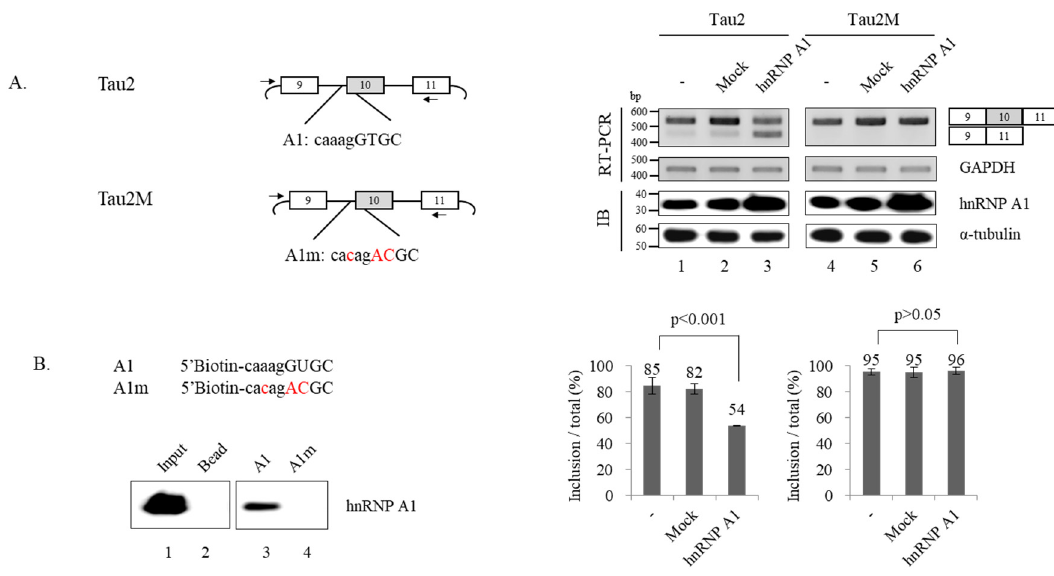
Figure 4. hnRNP A1 directly targets 3 ′ splice site of alternative exon 10 to modulate alternative splicing of exon 10. ( A ) (Left) Schematic of Tau2 and Tau2M minigene with potential hnRNP A1 binding sequence (A1) and mutated sequences (A1m). The exon sequences are shown with upper case while the intron sequences are shown with lower cases. (Right) RT-PCR monitoring of alternative exon 10 splicing within Tau2 and Tau2M minigenes in hnRNP A1 or control pcDNA expressed cells. Bar charts of RT-PCR are shown. ( B ) (Upper) 5 ′ biotin labeled RNA oligo sequences of A1 and A1m. (Lower) RNA immunoprecipitation assay monitoring binding of hnRNP A1 to A1 or A1m.